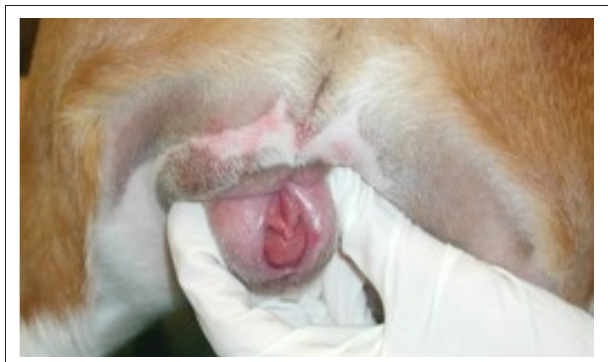
FIGURE 1: Photograph showing spherical clitoral mass.